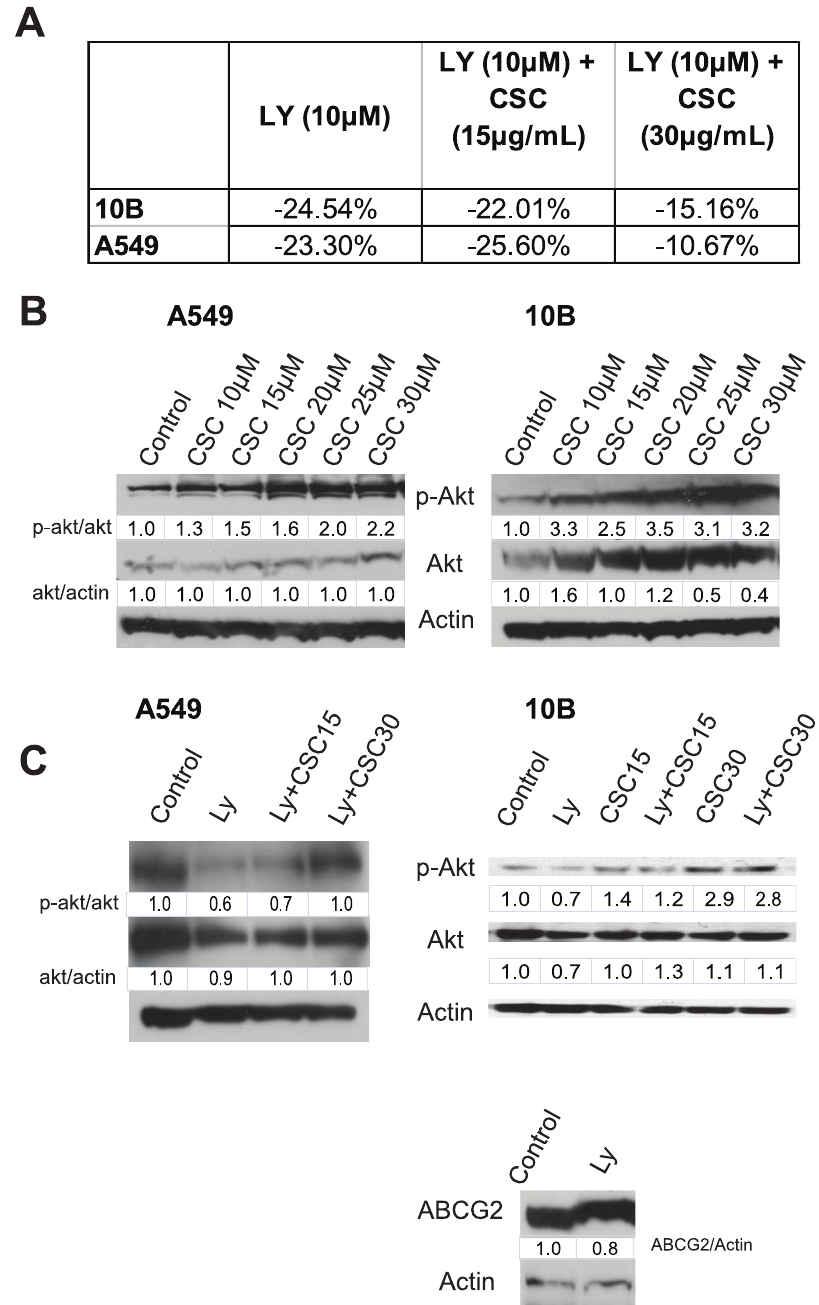
Figure 4. Inhibition of PI3K reduces CSC-mediated doxorubicin efflux. ( A ) PI3K inhibitor LY294002 (LY) decreases doxorubicin efflux in cell lines 10B and A549. Values are derived from flow cytometric analysis of intraceulluar doxorubicin levels, and are computed relative to non-LY treated controls. ( B ) Western blot analysis showing the change in levels of phospho-Akt and Akt with increasing dosage of CSC. ( C ) Western blot analysis showing the reversal of Akt activation by treatment with LY, and the expression of ABCG2 in the presence of LY.